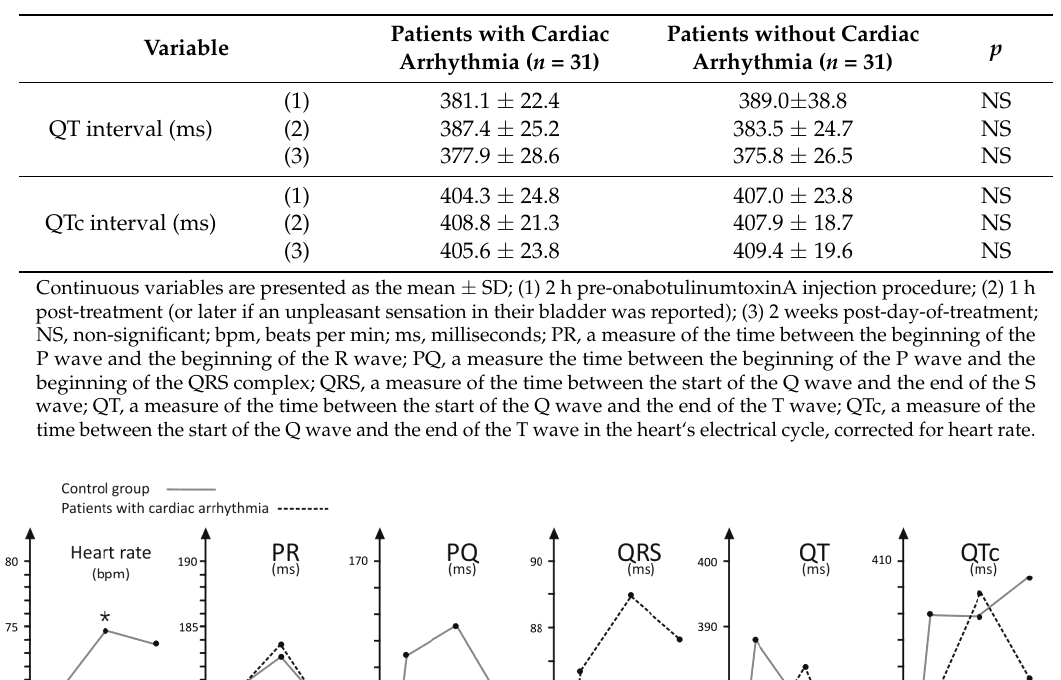
Table 4. Results of blood pressure measurements in overactive bladder (OAB) patients during the study. Patients with Cardiac Variable